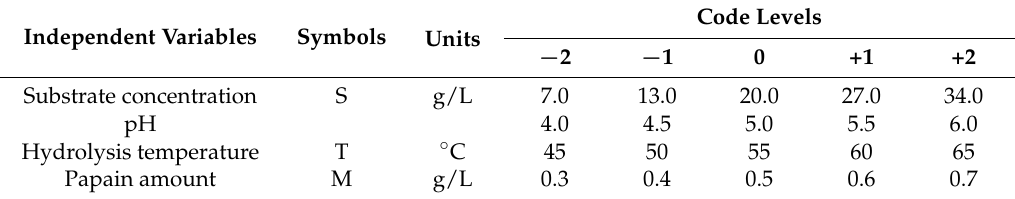
Table 1. Experimental range and levels of the independent